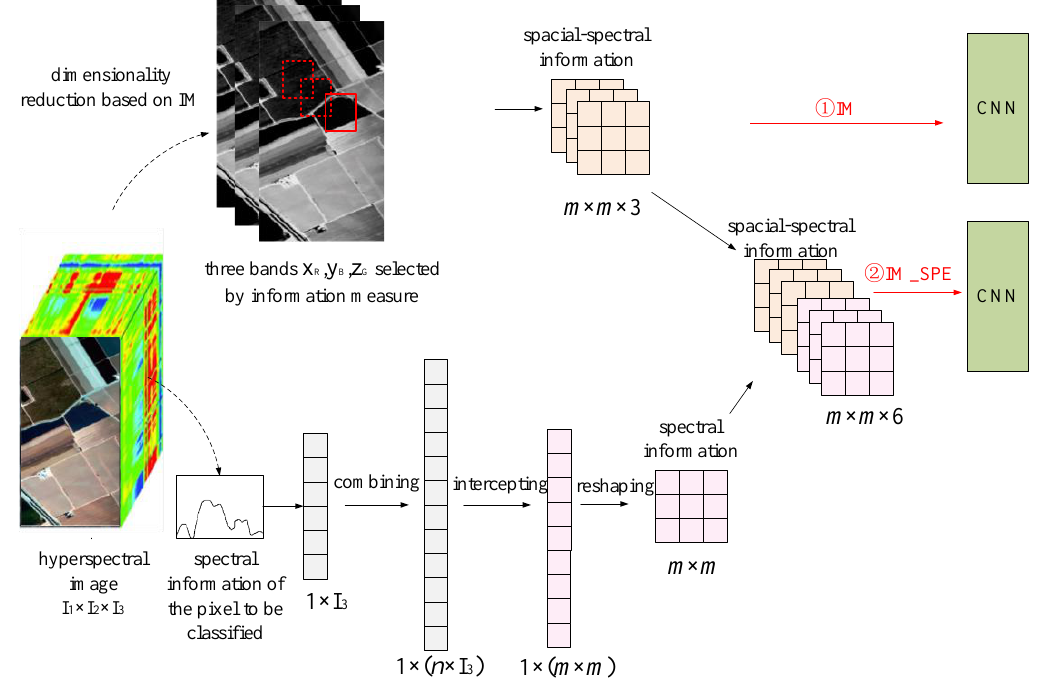
Figure 5. The principle of dimensionality reduction based on the integration of information measure and spectral information.